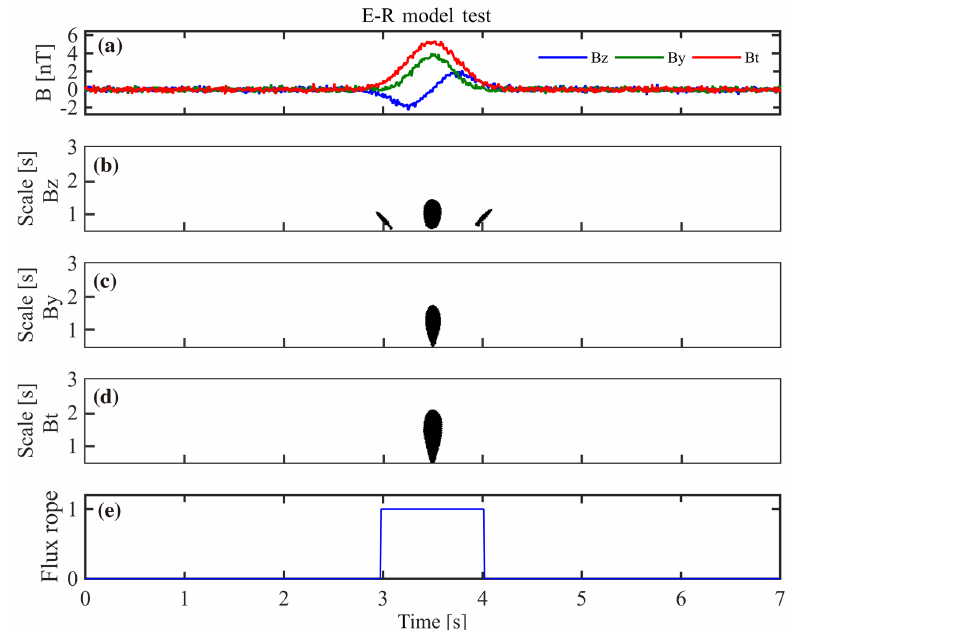
Figure 5. The test results on E – R model with a threshold of 0.9. (a) Three variables B z , B y and B t from E – R model with 10% random noise; (b–d) the correlation coefficients ( ≥ 0 . 9) between the variables of B z , B y and B t and the TFC, respectively; (e) the index when the virtual spacecraft cross the flux rope (if the spacecraft cross the flux rope, the index is 1; if not, the index is 0). The duration of the index presents the timescale of the flux rope. The scale on the vertical axes of (b–d) is the same as in Fig. 4.